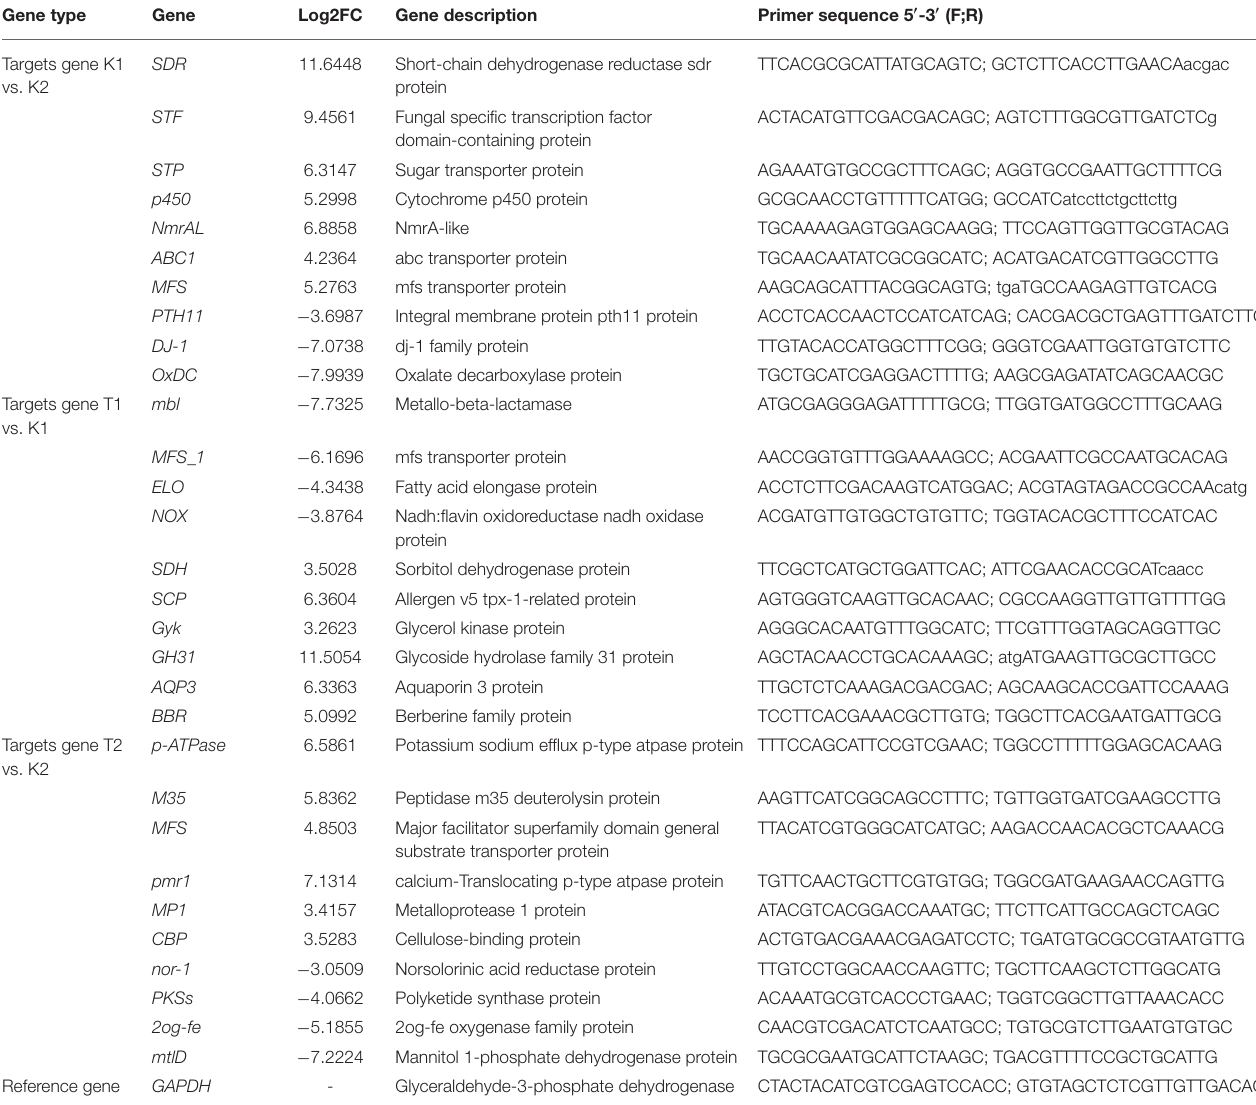
TABLE 1 | The primer sequences of DEGs and reference gene for qRT-PCR. Gene type Gene Targets gene K1 vs.